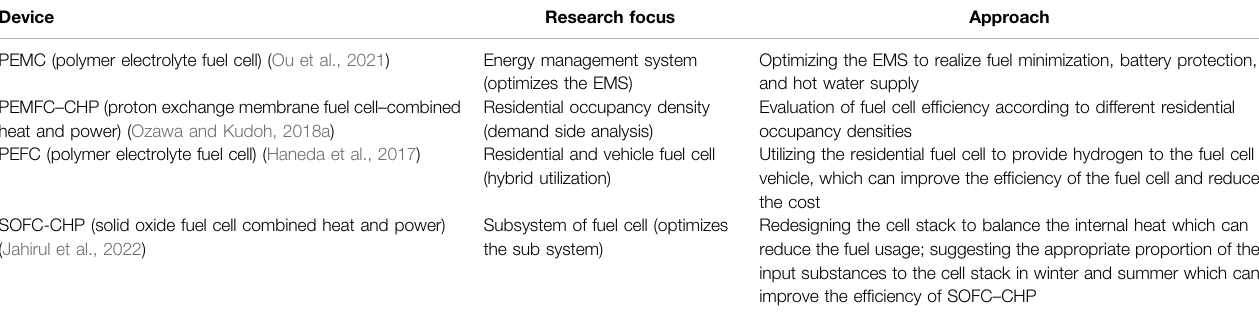
TABLE 1 | Typical approaches of the residential fuel cell ef fi ciency improvement. Device Research focus